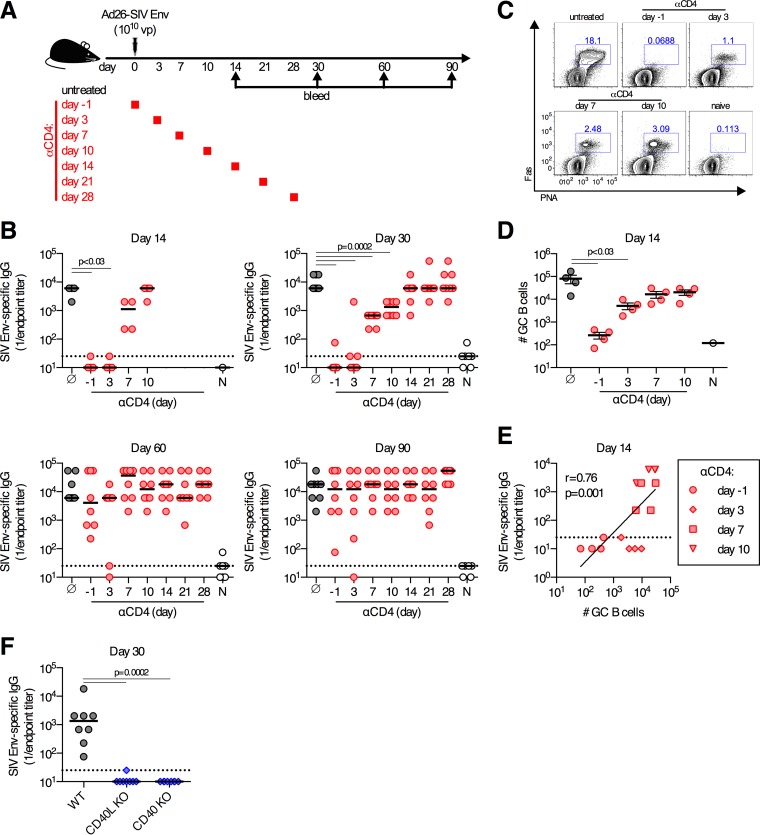
Delayed development of antibody responses following depletion of CD4+ T cells. (A) C57BL/6 mice were depleted of CD4+ T cells at the indicated days or left untreated and immunized intramuscularly with 1010 vp of Ad26-SIV Env. (B) SIV Env-specific serum-binding antibody titers at the indicated days postimmunization. Gray, no anti-CD4 treatment; red, anti-CD4 given on the indicated day; white, naive animals. (C and D) Representative flow cytometry plots (C) and absolute numbers (D) of germinal center (GC) B cell responses in the iliac LNs on day 14 postimmunization, with gating on CD3ε− CD19+ cells. (E) Spearman correlation analysis of the number of germinal center B cells in iliac LNs and serum SIV Env-specific binding antibody titers on day 14 postimmunization in mice treated with anti-CD4 at the days indicated. (F) SIV Env-specific serum-binding antibody titers in wild-type (WT), CD40L KO, or CD40 KO mice immunized with 109 vp of Ad26-SIV Env. Each dot represents an individual mouse, and the line is the median (B and F) or the mean ± the standard error of the mean (D). The horizontal dotted line denotes the limit of detection of the assay (for panel B, n = 4/group from one experiment [day 14] or n = 8/group pooled from two experiments [days 30, 60, and 90]; for panel D, n = 4/group from one experiment; for panel F, n = 8/group pooled from two experiments).